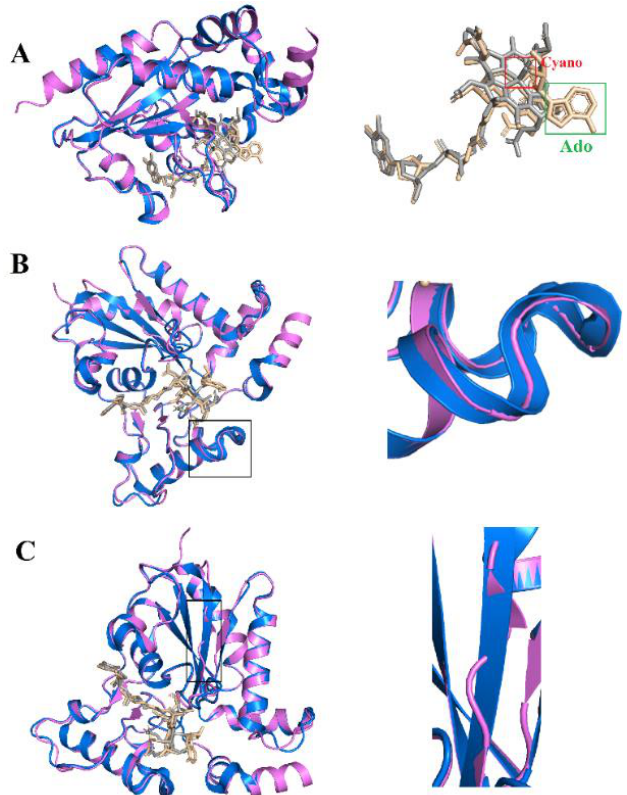
Figure 5. Structural comparison of MMACHC combined with CNCbl and AdoCbl, respectively: ( A ) structural comparison between two types cobalamin; ( B ) differences between MMACHC with CNCbl and AdoCbl on helix circled by black box; ( C ) differences between MMACHC with CNCbl and AdoCbl on β -sheet circled by black